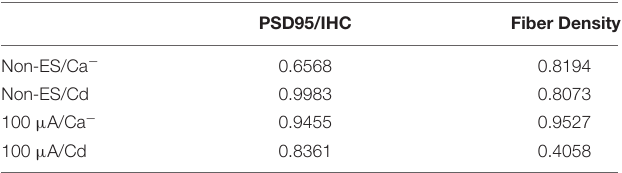
TABLE 2 | P value of fiber density and PSD95/IHC ratio of the Non-ES/CCB and 100 µ A/CCB group compared with Non-ES group.